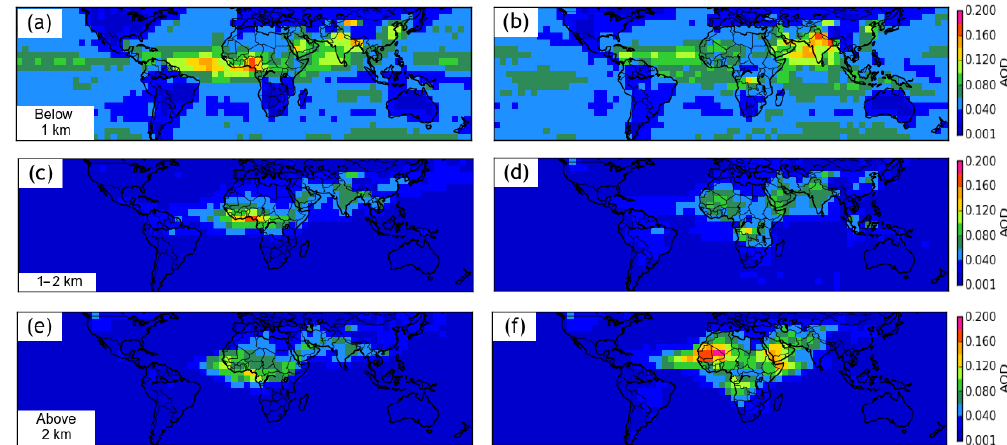
Figure 7. Mean CATS AOD (1064nm) by season for (a) DJFMAM below 1kma.g.l., (b) JJASON below 1kma.g.l., (c) DJFMAM 1– 2kma.g.l., (d) JJASON 1–2kma.g.l., (e) DJFMAM above 2kma.g.l. and (f) JJASON above